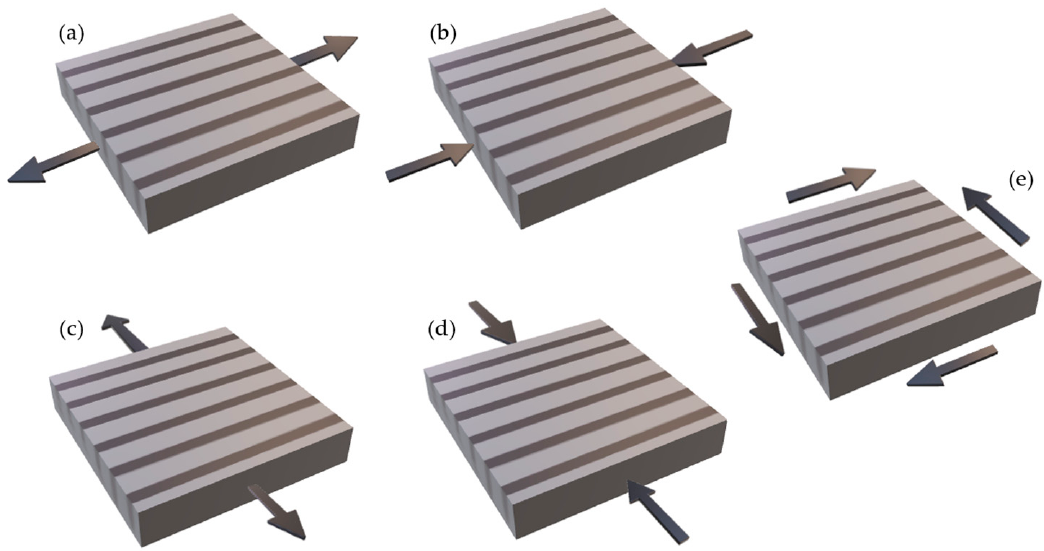
Figure 13. Basic strength parameters of unidirectional lamina for in-plane loading, ( a ) longitudinal tensile, ( b ) longitudinal compressive, ( c ) transverse tensile, ( d ) transverse compressive, and ( e ) in-plane or interlaminar shear.